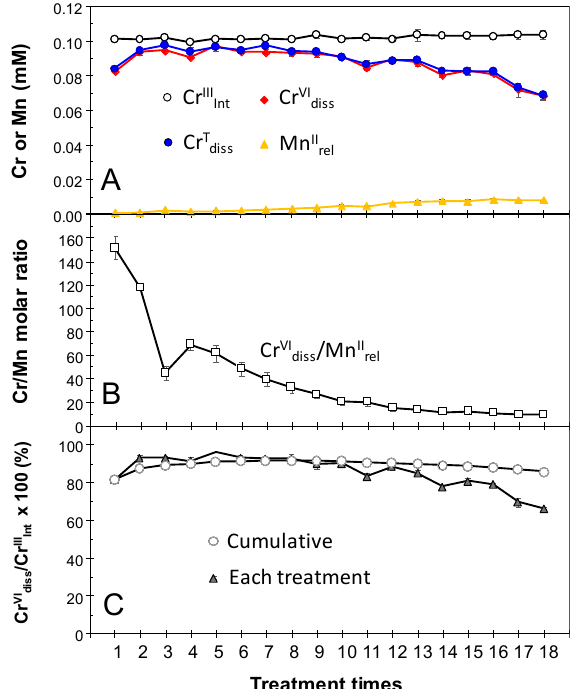
Figure 2. Repeated treatments of newly formed biogenic manganese oxides (BMOs; 1 mM as Mn) with 0.1 mM Cr(NO 3 ) 3 under aerobic conditions at pH 6.0 (100 mM MES buffer). ( A ) Concentrations of initial Cr(III) (Cr IIIInt ), total Cr dissolved (Cr Tdiss ), Cr(VI) dissolved (Cr VIdiss ), and Mn(II) released (Mn IIrel ). ( B ) Molar ratio of Cr VIdiss /Mn IIrel . ( C ) Percentages of conversion to Cr VIdiss . Bathing solutions were renewed every 24 h for 18 days. Data are shown as mean ± standard deviation (n = 3).